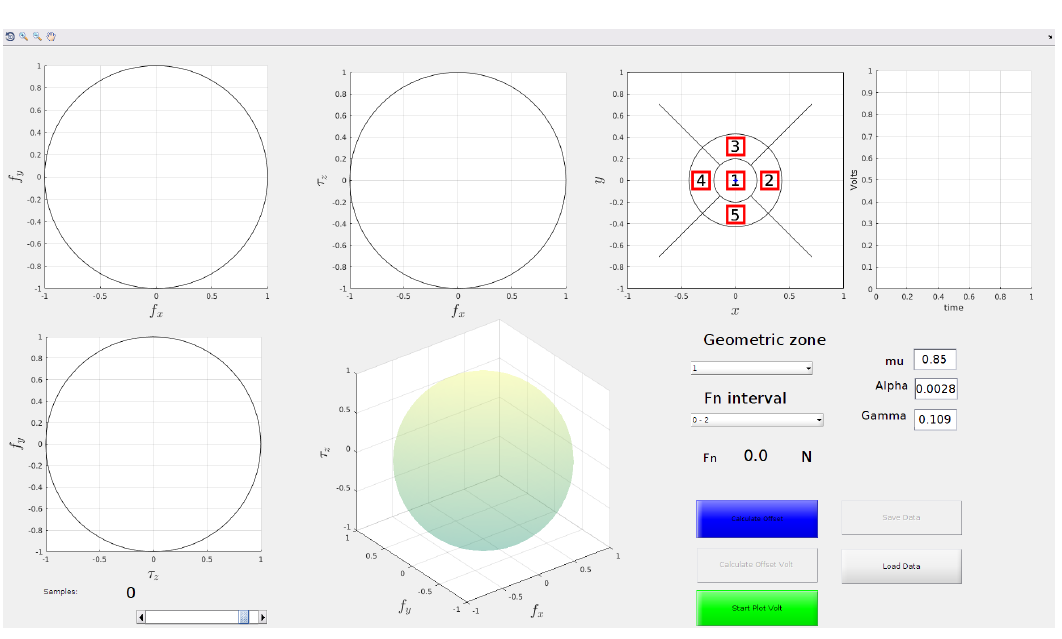
Figure 10. Graphical user interface (GUI) used in the calibration